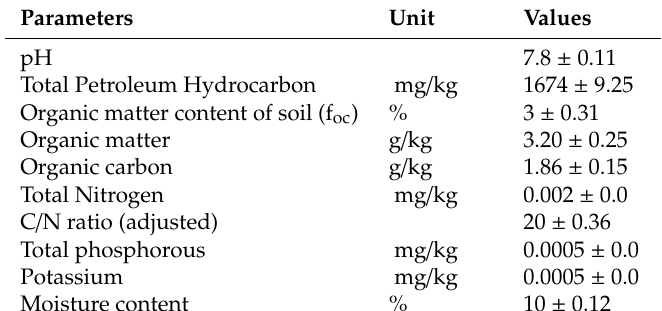
Table 2. Chemical characteristics of oil-contaminated soil used in the study.